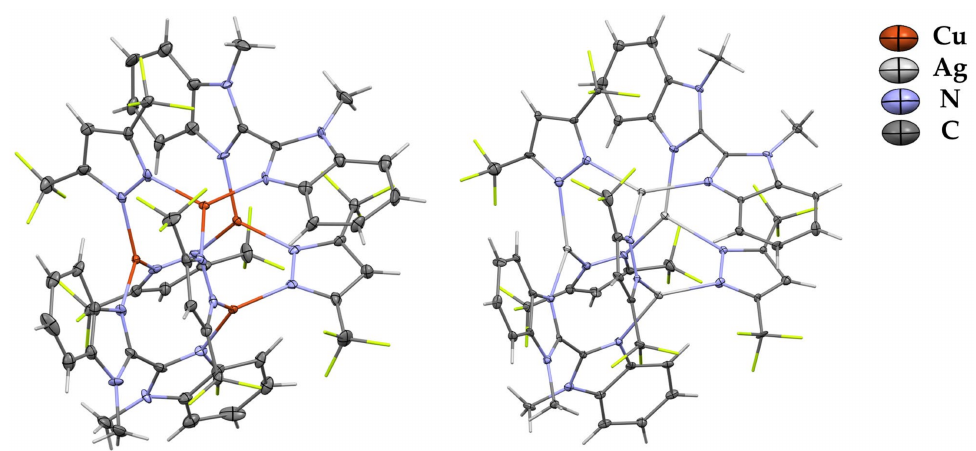
Figure 1. XRD structures of complexes 1 and 3 with thermal ellipsoids set at the 30% probability level. Hydrogen and fluorine atoms are sticks for clarity.